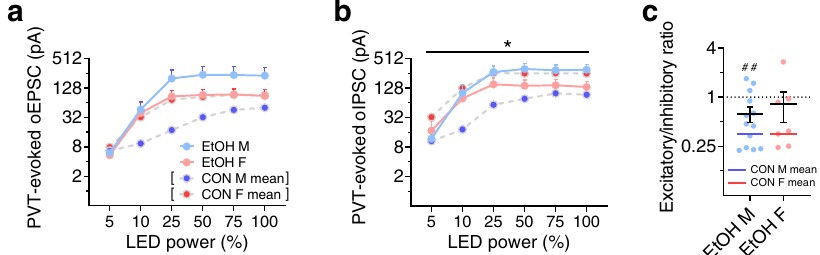
Fig. 7 A history of voluntary binge alcohol drinking induces a female-like phenotype in male PVT-BNST CRF synapses. a – b Power-response curves for optically-evoked EPSCs (oEPSCs, a ) and IPSCs (oIPSCs, b ) in response to optical stimulation of ChR2 from PVT axon terminals. N ’ s = 4 EtOH M, 12 cells and 3 EtOH F, 8 cells. Data in a and b are presented as mean values + SEM. Means for CON cell data in Fig. 3 are represented in this fi gure by blue and red lines for CON M and F, respectively. a 3xRM-ANOVA on oEPSCs: main effect of power ( F 5,175 = 86.4, P < 0.0001, not indicated) and a trend for an EtOH × power interaction ( F 5,175 = 2.25, P = 0.052), but no other effects or interactions ( P s > 0.15). b 3xRM-ANOVA on oIPSCs: main effect of power ( F 5,175 = 103.4, P < 0.0001, not indicated) and a sex × EtOH interaction ( F 1,35 = 4.71, * P = 0.037), but no other effects or interactions ( P s > 0.05). c oEPSC/ oIPSC ratio in BNST CRF neurons of EtOH mice. Data are presented as mean values± SEM. EtOH M have E/I ratios below 1 (one-sample t -test: t 13 = 3.18, = 1.01, P = 0.321). EtOH F does not have an E/I ratio below 1.0 ## P = 0.007), which does not differ from that of CON M (two-tailed unpaired t -test: t 23 (one-sample t -test: t 6 = 1.71, P = 0.137), however, this ratio does not signi fi cantly differ from CON F (two-tailed unpaired t -test: t 20 = 1.84, P = a unique role for the PVT BNST circuit in alcohol drinking that is independent of the role of the PVT in general appetitive reward.